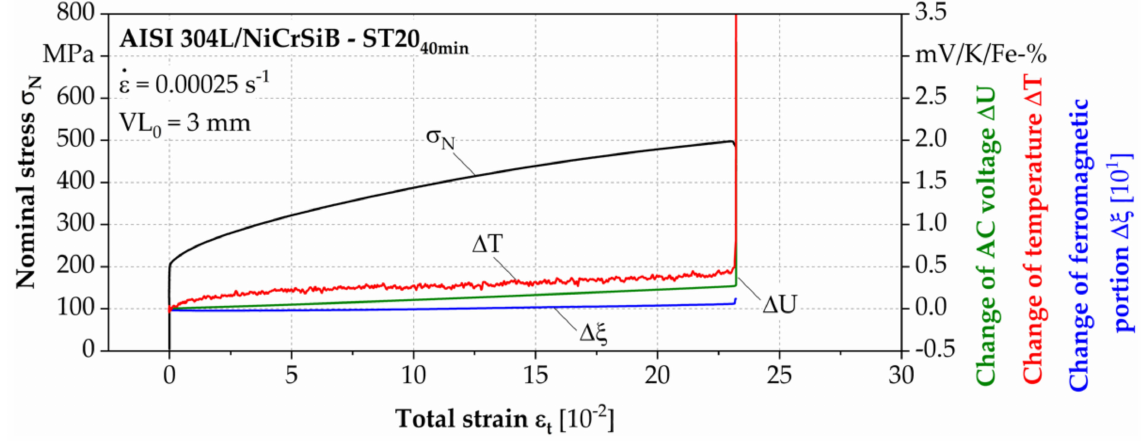
Figure 16. Instrumented low-strain tensile test with ST20 40min .